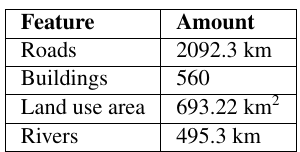
Table 2: Mapping results. Source: